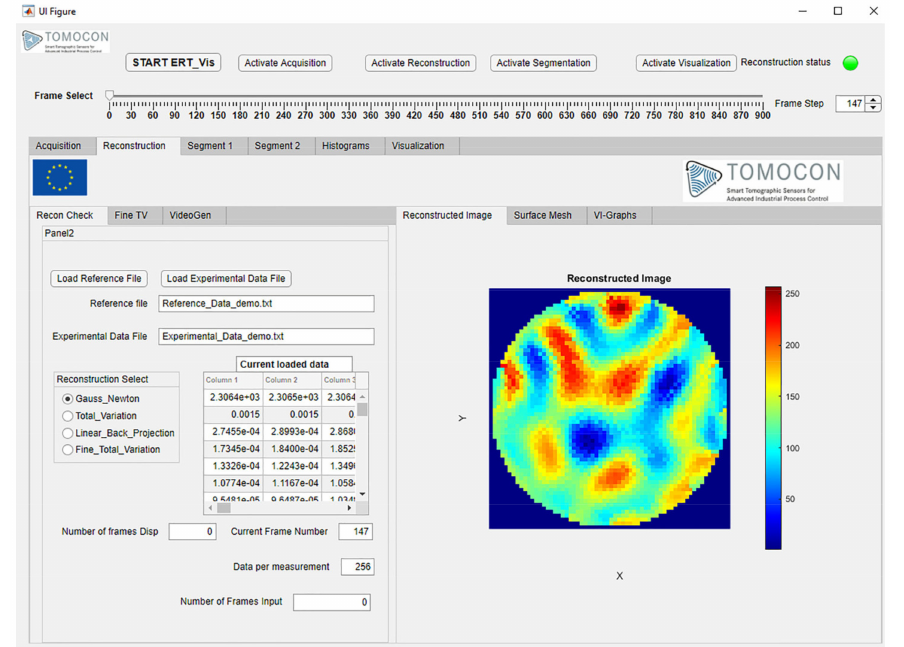
Figure 6. ERT-Vis Reconstruction module tab.